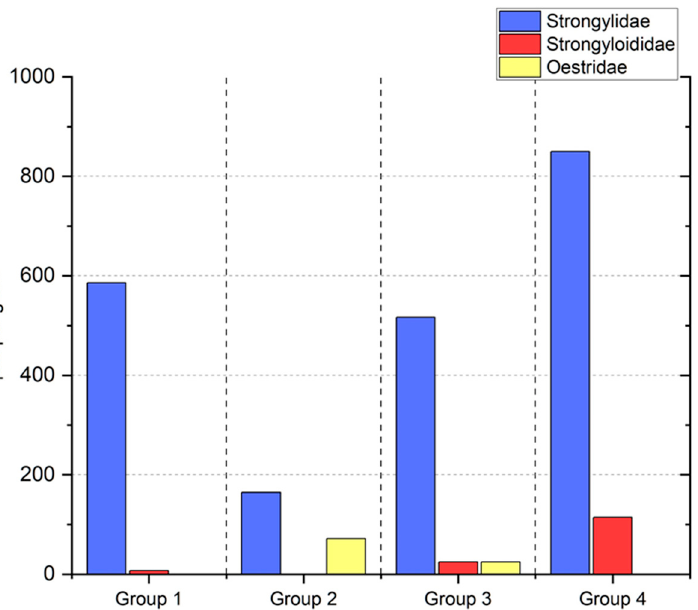
Figure 7. Mean numbers of eggs/larvae in 1 g of faeces in the experimental groups (group 1—supplemented with soybean oil, group 2—supplemented with linseed oil, group 3—supplemented with linseed oil and vitamin E, group 4—control group). Table 2. Multiple comparisons between the groups (group 1—supplemented with soybean oil,